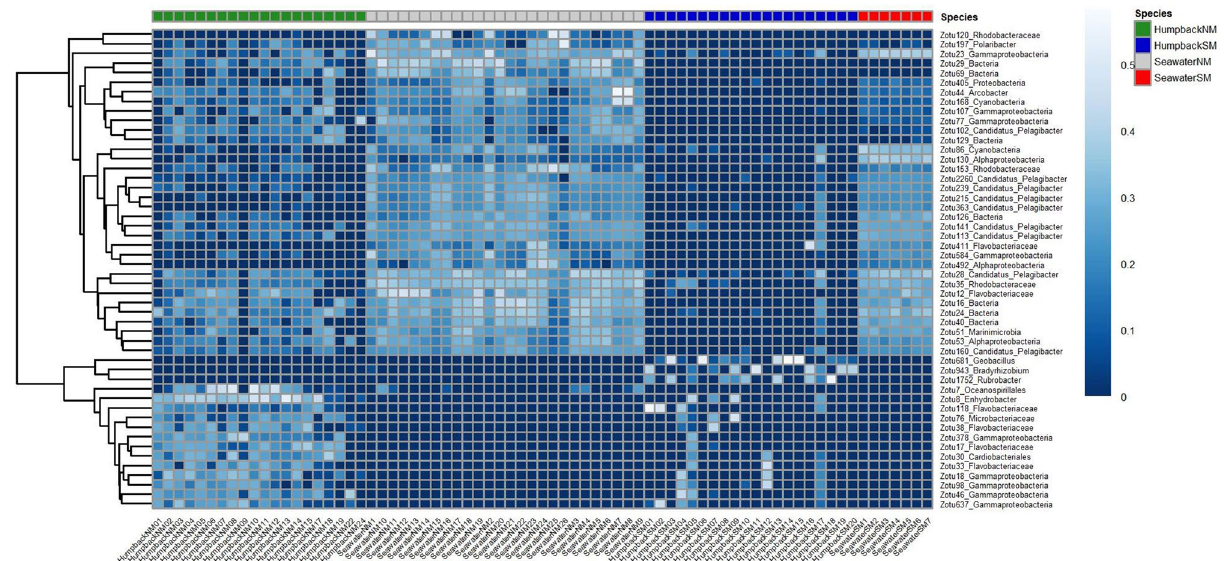
Figure 3. Heatmap of fourth-root transformed relative abundance of the 50 most abundant zOTUs that were identified as significantly different when comparing the microbiota in the blow of humpback whales at the beginning of their fasting (HumpbackNM) and humpback whales at a later stage of fasting (HumpbackSM) and their corresponding seawater samples (SeawaterNM,